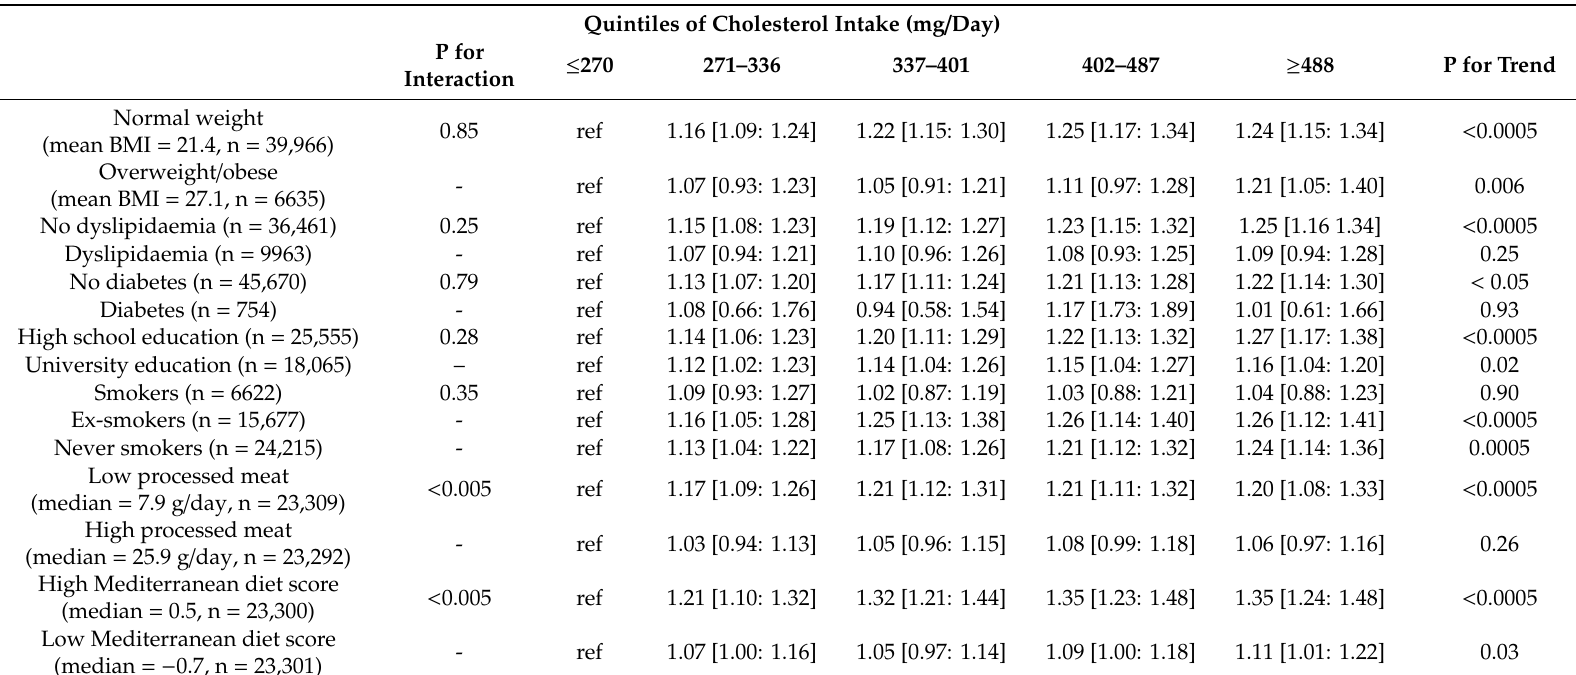
Table 4. Subgroup analysis: stratified multivariate cox proportional hazard models for incident hypertension risk related to daily cholesterol consumption. Quintiles of Cholesterol Intake (mg /